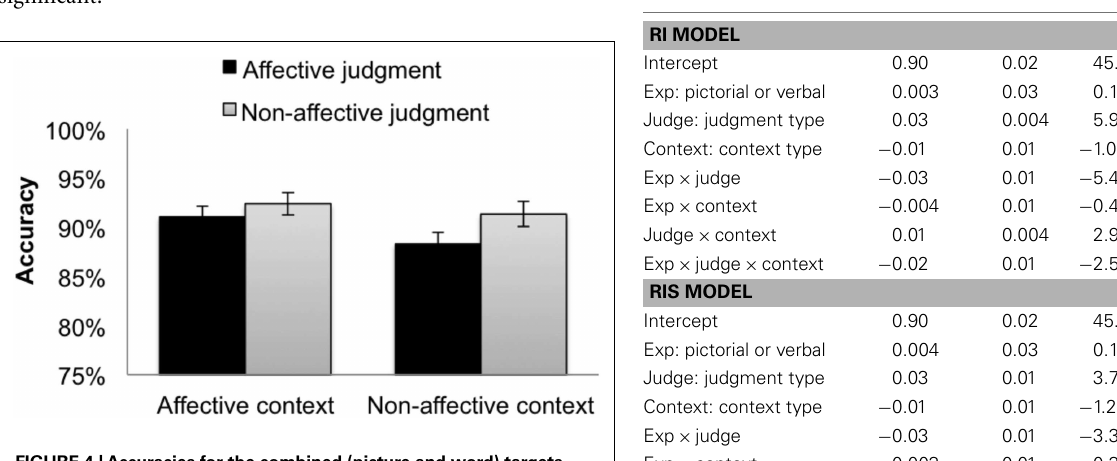
FIGURE 4 |Accuracies for the combined (picture and word) targets when participants made affective judgments (dark bars) and non-affective judgments (light bars) in the affective context group (left bars) and the non-affective context group (right bars). The error bars indicate subject-wise SEM.